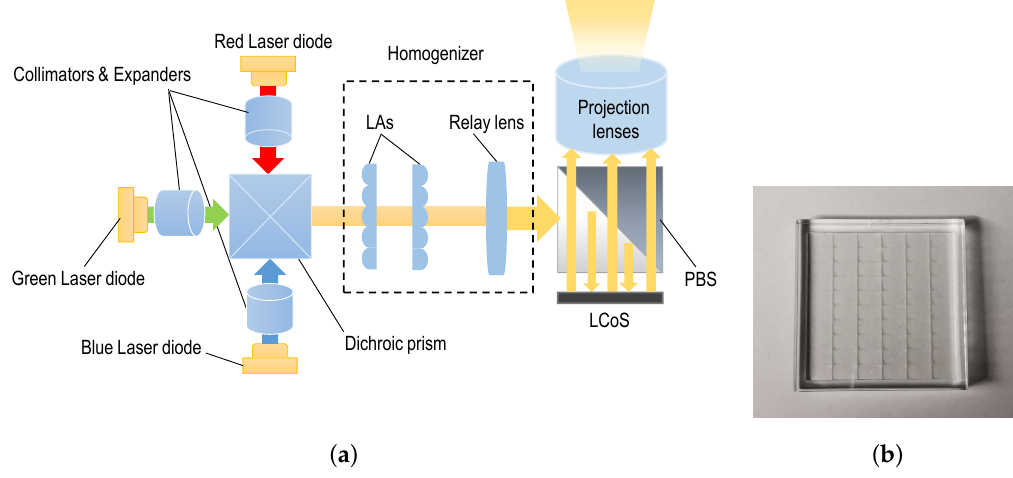
Figure 6. Demonstrator setup and manufactured LA. ( a ) Demonstrator schematic for the performance investigation; ( b ) The manufactured